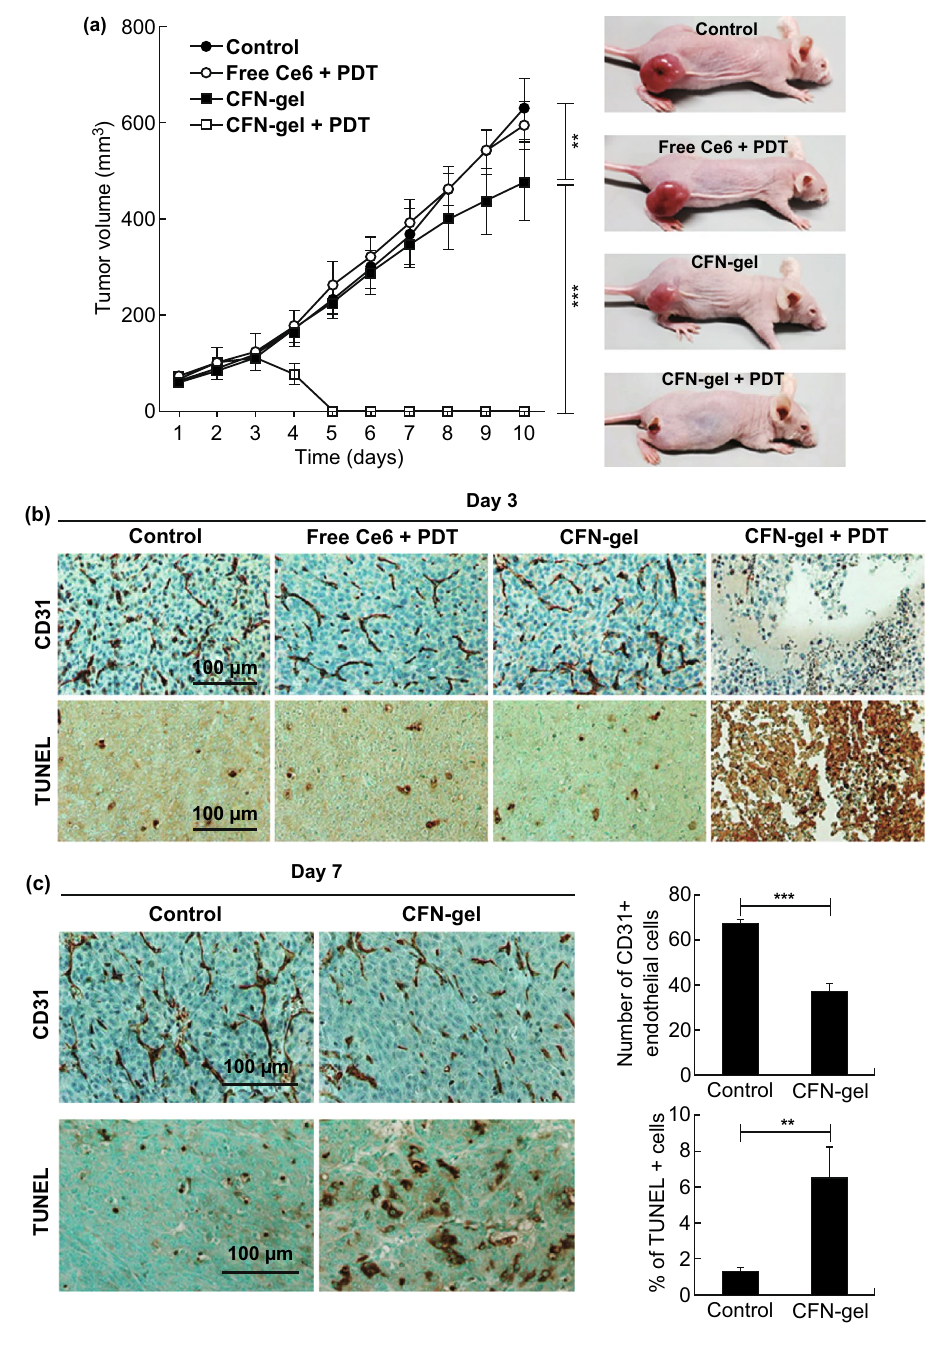
Fig. 7 Anti‑tumor activity of CFN‑gel combined with PDT in vivo. a Left: tumor growth curves of mice. Control group ( n = 7), free Ce6 + PDT ( n = 5), CFN‑gel ( n = 7) and CFN‑gel + PDT ( n = 5). PBS, free Ce6 or Ce6–fucoidan was injected intravenously on day 1. Light illumination (670 nm, 50 mW cm −2 , 20 J cm −2 ) of the tumors was conducted on day 2 for PDT. Right: representative photographs of the mice obtained on day 10, b immunohistochemical staining of CD31 (for tumor blood vessels) and TUNEL (for apoptotic cell death) of tumor sections collected from different groups of mice at 24 h after PDT, c left: micrographs of immunohistochemical staining of CD31 and TUNEL‑stained tumor sec‑ tions collected from control and CFN‑gel groups of mice at day 7. Right: quantitative analysis of CD31 and TUNEL assays in the tumor sec‑ tions. ** P < 0.01, *** P <